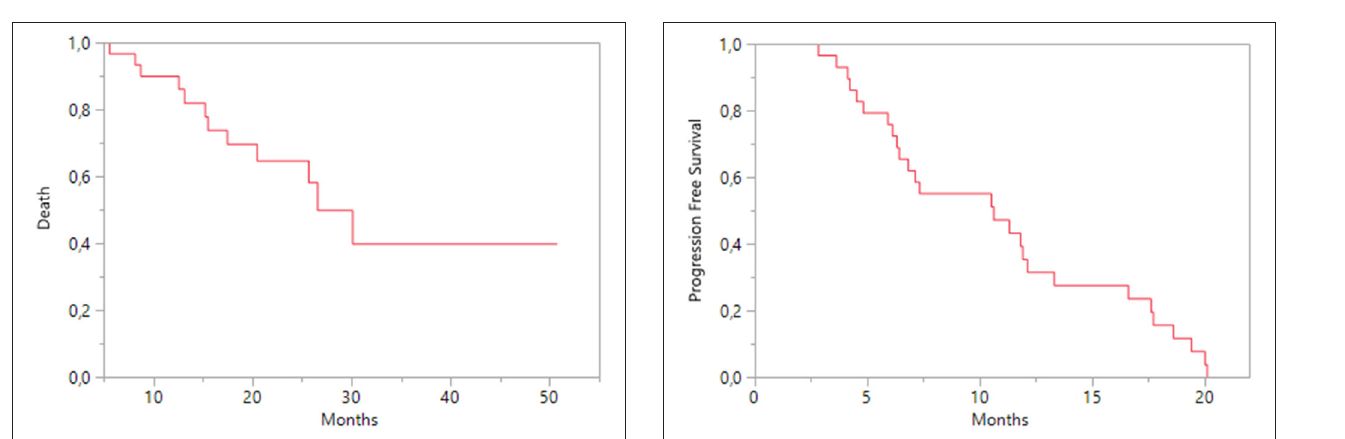
FIGURE 3 | Kaplan-Meier estimates of Progression Free Survival on pazopanib treatment.